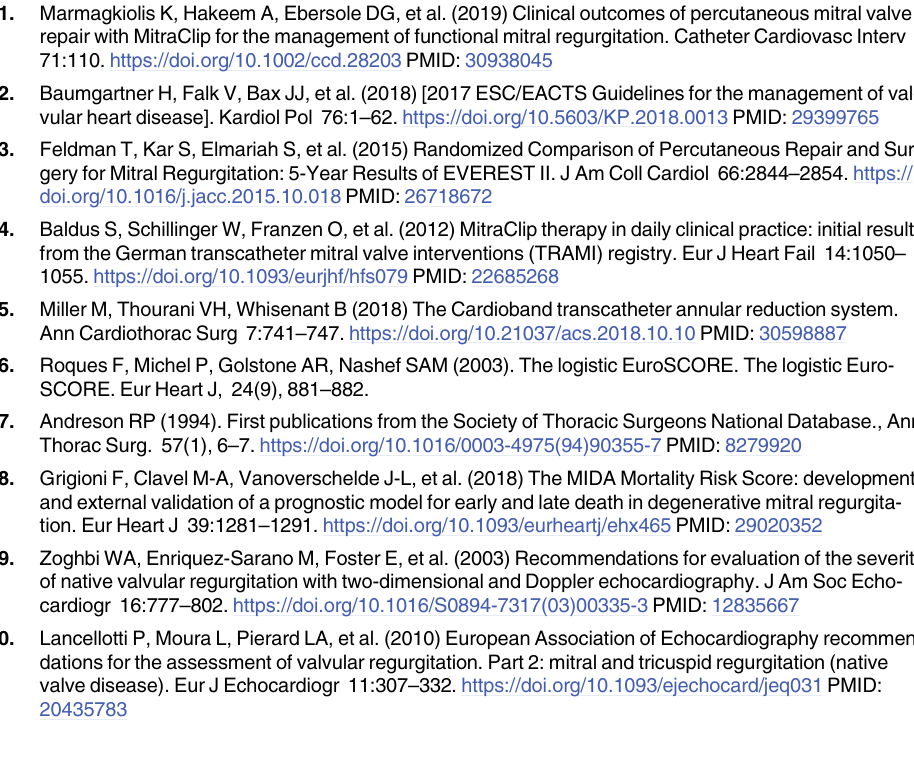
S4 Fig. The Kaplan-Meier curve for grades of the modified MIDA Score regarding the combined